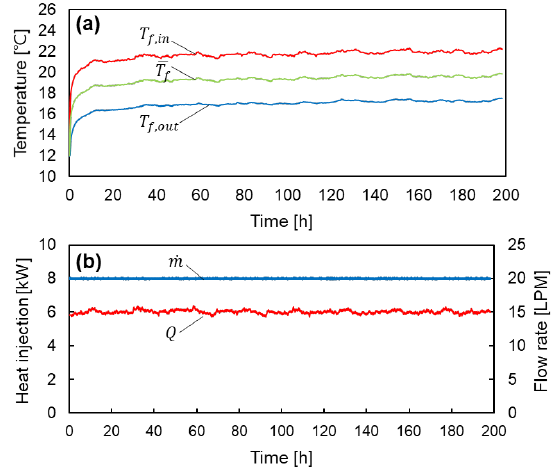
Figure 5. Measurement data of the TRT: ( a ) the temperature data of the inlet and outlet; and the average temperature of the Pt-100 sensors; ( b ) the heat injection and flow rate.